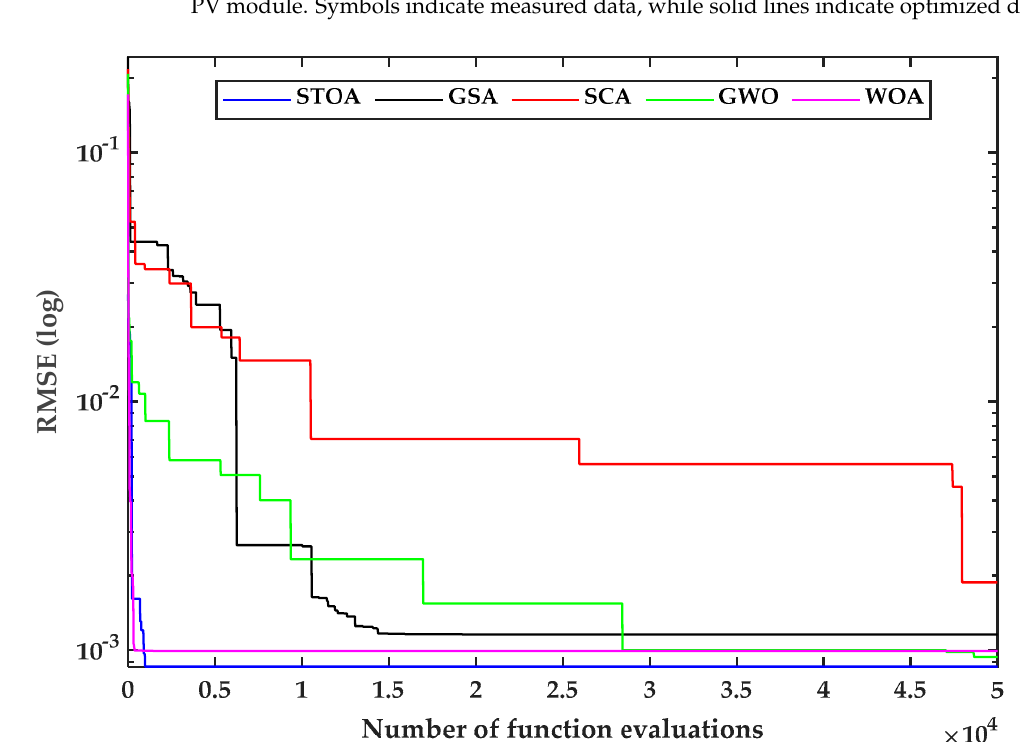
Figure 5. Convergence plot for the RTC France solar cell.